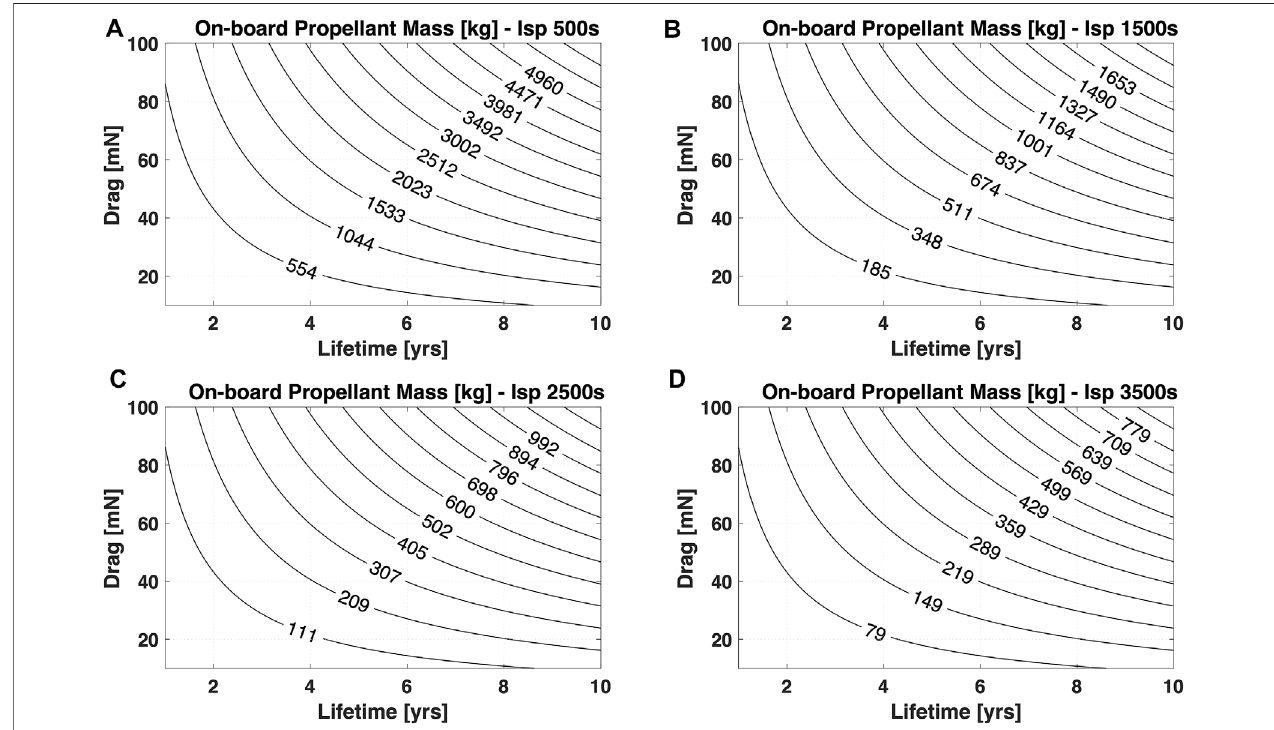
FIGURE 1 | Onboard propellant mass required to compensate drag levels in the 10 – 100 mN range for 500 s (A) , 1500 s (B) , 2500 s (C) , and 3500 s (D) speci fi c impulse thruster. Mission duration is in the 1 – 10 -year range.